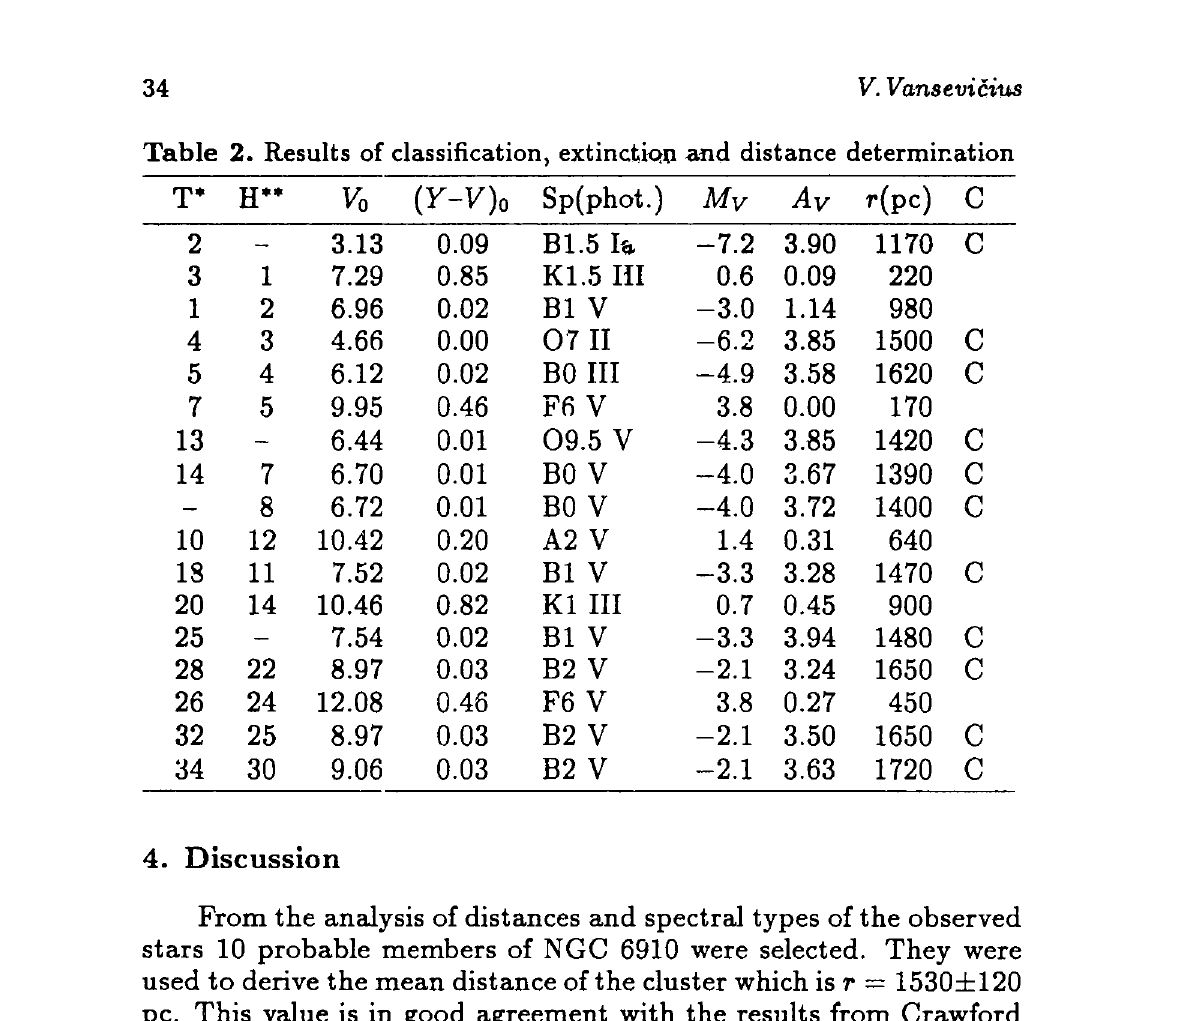
Table 2. Results of classification, extinction and distance